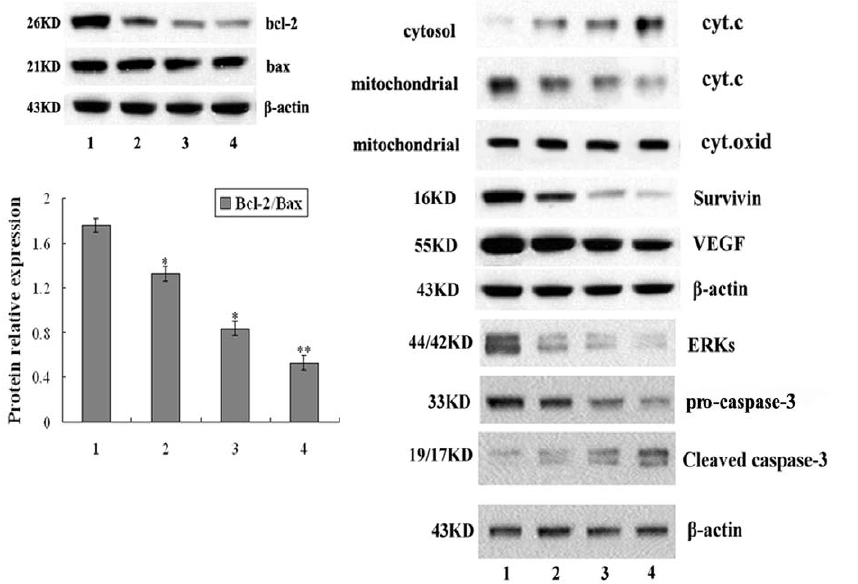
Figure 4. Expression of Bcl-2, Bax, Survivin, ERK, cytochrome C, Caspase-3 and VEGF in 4T1 cells after 48 h treatment of fucoidan detected by Western blot. Expression of the b -actin gene was used as the internal control. Data are mean 6 SD of one representative experiment performed in triplicate. Fucoidan significantly decreased the expression of Bcl-2, did not modulate the expression of Bax, but the ratio Bcl-2/Bax was decreased. Fucoidan also decreased the protein expression of Survivin and phosphorylated ERKs in 4T1 cells. Fucoidan treatment significantly increased levels of cytochrome C in the cytoplasm, whereas there was a significant corresponding decline of mitochondrial cytochrome C. Cytochrome oxidase (subunit II) was as sample loading control (cyt. oxid). The level of pro-caspase-3 decreased after fucoidan treatment, while the level of caspase-3 cleavage protein increased after fucoidan treatment. Fucoidan decreased VEGF expression in 4T1 cells. Lane 1: control cells; lanes 2–4: 4T1 cells treated with 50, 100 and 200 m g/ml fucoidan respectively. * P , 0.05, vs. Control; ** P , 0.01, vs. Control.